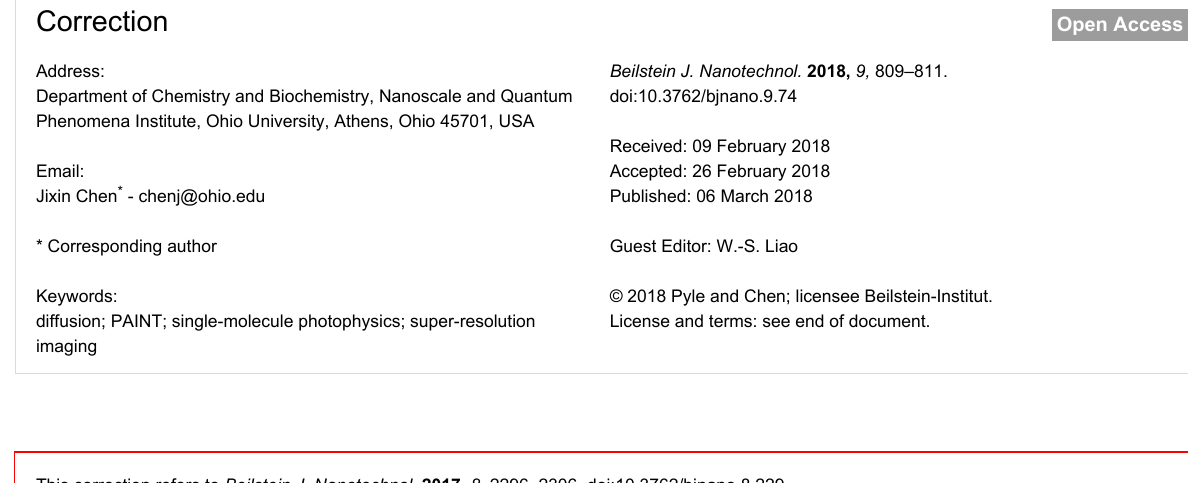
mistakes. In Figure 7d and in Figure 8f the x -axis labeled unit should be W cm − 2 instead of mW cm − 2 . Figure 1 in this Correction shows the corrected Figure 7 of the original publication and Figure 2 shows the corrected Figure 8 of the original publication. On page 2304, left column line 13 from the bottom 4.5 s should be 7.5